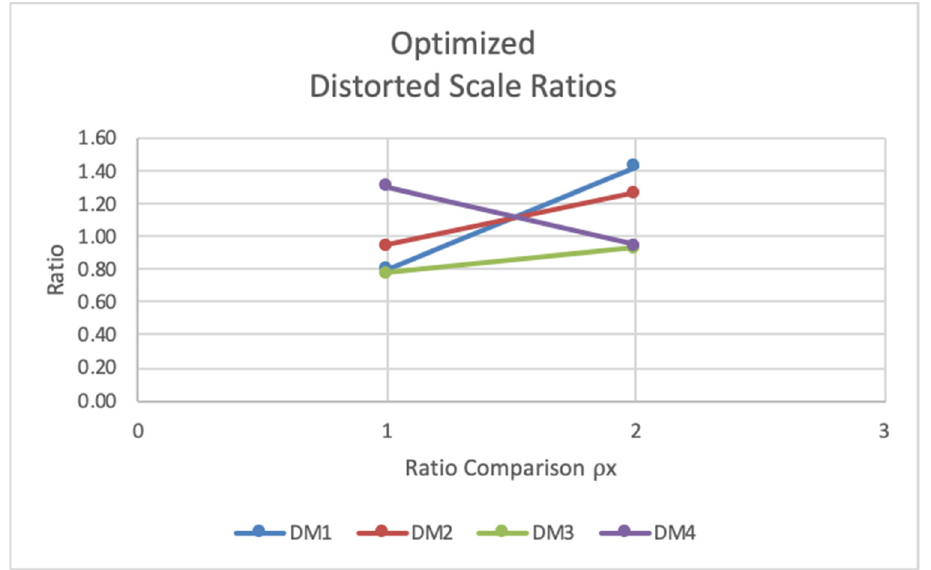
Figure 14. Case #18 adjusted distorted scale ratios (extreme bias). Table 6. Optimization case distortion disparity